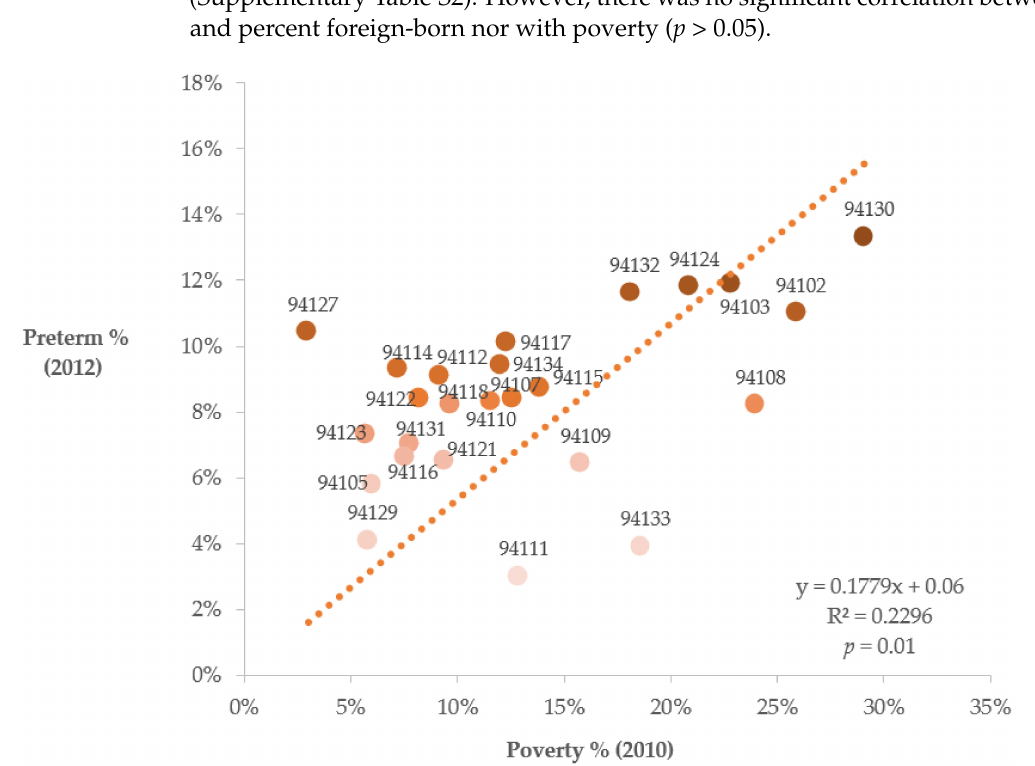
Figure 2. The correlation between percent PTB ( y -axis) and percent poverty ( x -axis) by neighbor- hood (zip code) in SF with a significant p -value (0.01) and R 2 value = 0.23 positive correlation trends. The darker the gradient color, the higher PTB % and Poverty %, y = Preterm % (2012), x = Poverty %